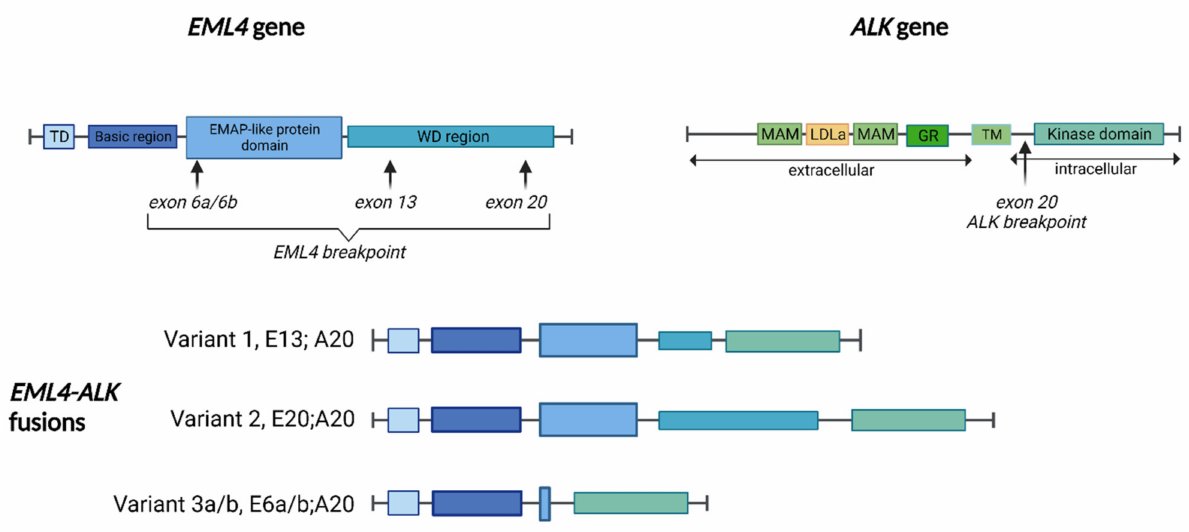
Figure 1. The EML4-ALK gene fusions: three major EML4-ALK variants are represented here, showing where the ALK kinase domain is inserted into the EML4 protein. Breakpoints in EML4 and ALK that generate different variants are marked with black arrows. Abbreviations: ALK, anaplastic lymphoma kinase; EMAP, echinoderm microtubule-associated protein; EML4, echinoderm microtubule-associated protein like 4; GR, glycine-rich region; LDLa, low-density lipoprotein alpha domain; MAM, meprin, A-5 protein, and receptor protein-tyrosine phosphatase mu; TD, trimerisation domain; WD, tryptophan-aspartic acid region; TM, trans-membrane region.